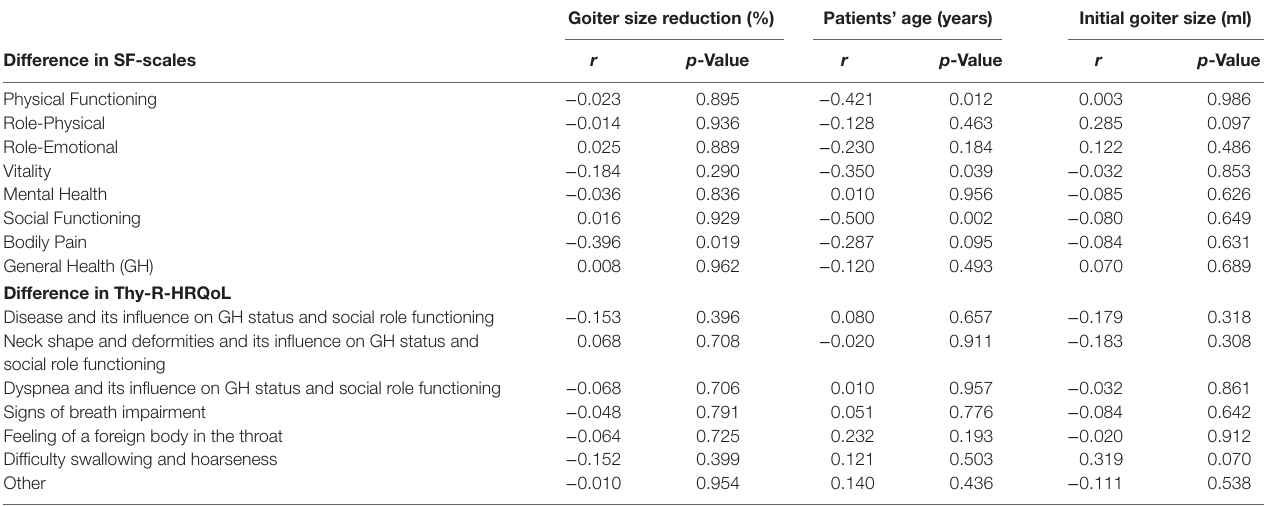
Pearson correlation coefficients (symbol r) were significant at p < 0.05.